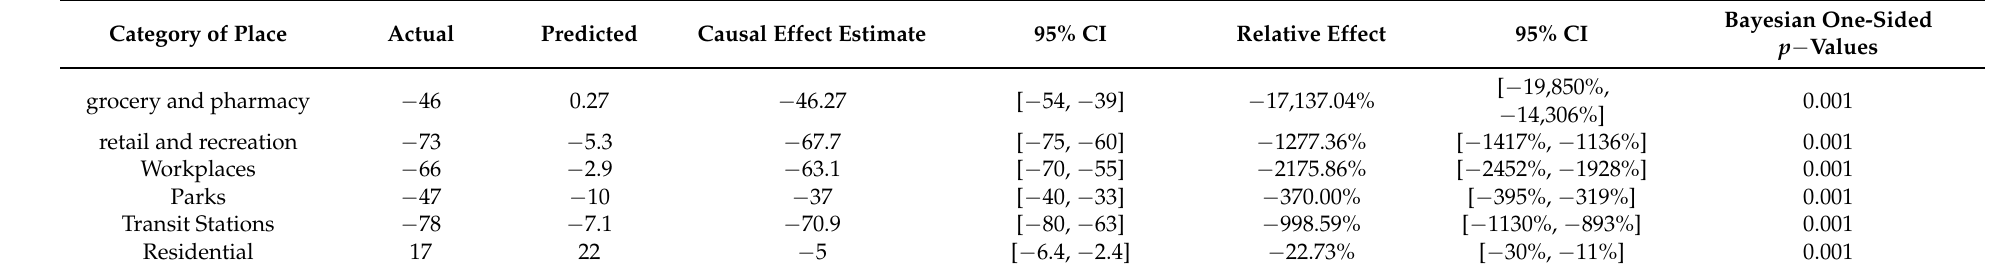
Table 4. Causal effect of lockdown Level 5 implemented 27 March 2020 for each category of places.